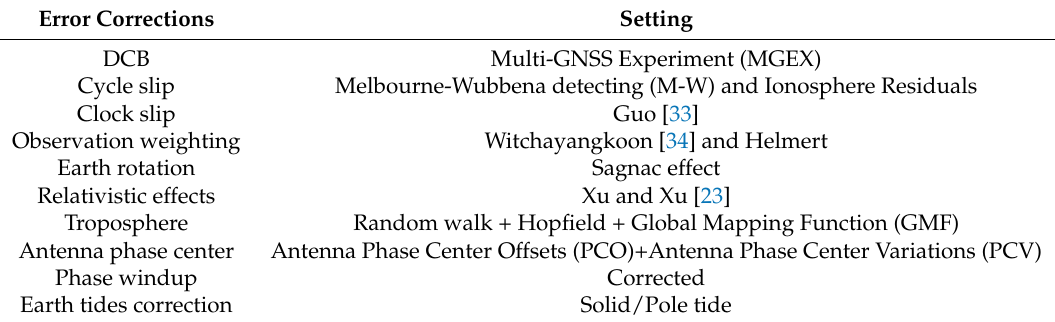
Table 3. Error corrections. Differential code bias